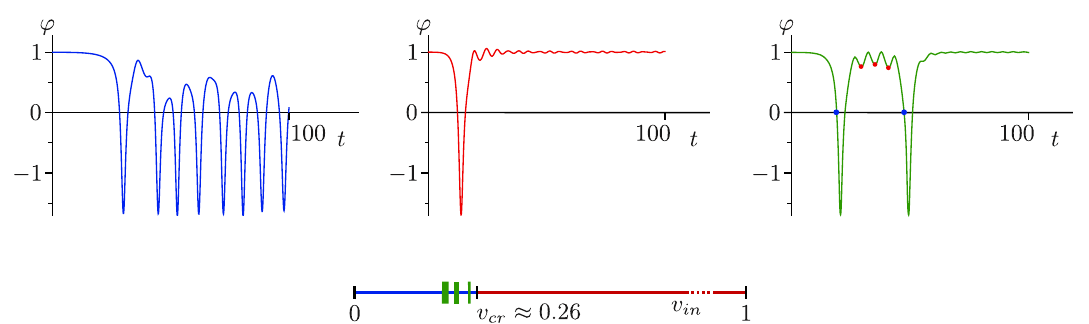
Figure 3.2: The behaviour of the field ϕ ( t , x ) at x = 0 as a function of time for = 0.15 (top left panel) the kink and different values of the initial velocity. With v in = 0.4 antikink form a bion and keep colliding, separating, and re-approaching. At v in (top center panel) the kinks separate after a single collision, leaving behind small = 0.2384 (top right panel), kinetic energy is ripples in the field. Finally, for v in transferred to vibrational modes during the first collision. If the resonance condition of Eq. (3.2) is met, the stored energy can be converted back during a second or later collision, allowing the kinks to escape. The time intervals used in Eq. (3.2) are indicated by blue and red dots. The bottom panel shows a schematic phase diagram of the possible outcomes of kink collisions, as a function of their initial velocities. The left, blue region corresponds to bion formation, the right, red region to single collisions, and the green intervals are reflection